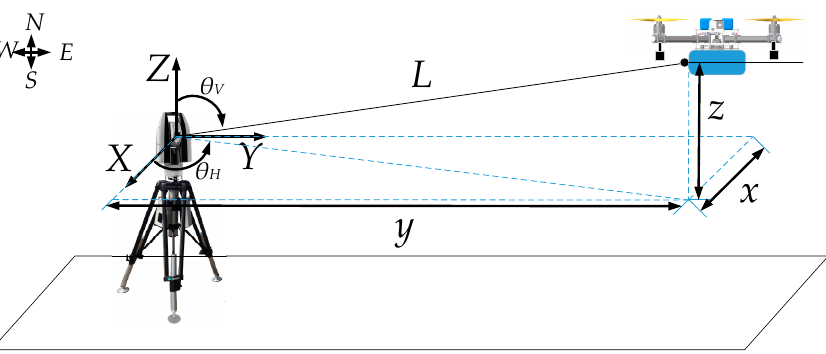
where L is the spatial distance from laser tracker to target ball; θ H is the horizontal angle; θ V is the vertical angle; and x , y , and z are the projection distances of the target ball on the X , Y , and Z axes of the laser tracker, respectively.